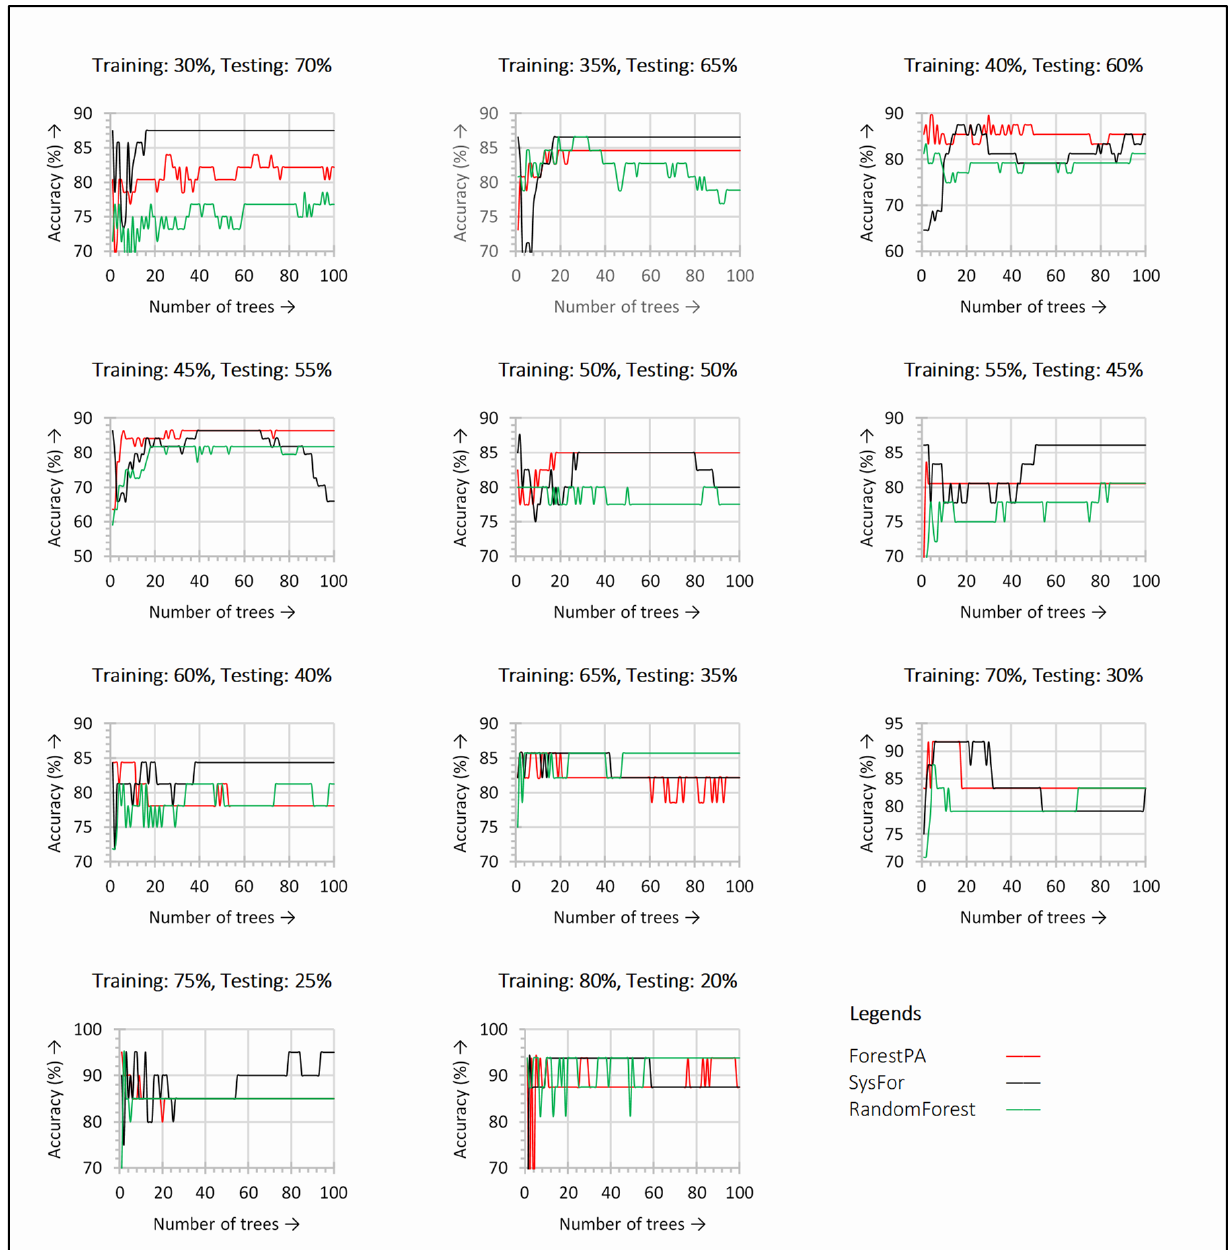
Figure 3. Detection accuracy with respect to change in number of trees in the decision forests observed for each training and testing split on Spanish acoustic dataset.